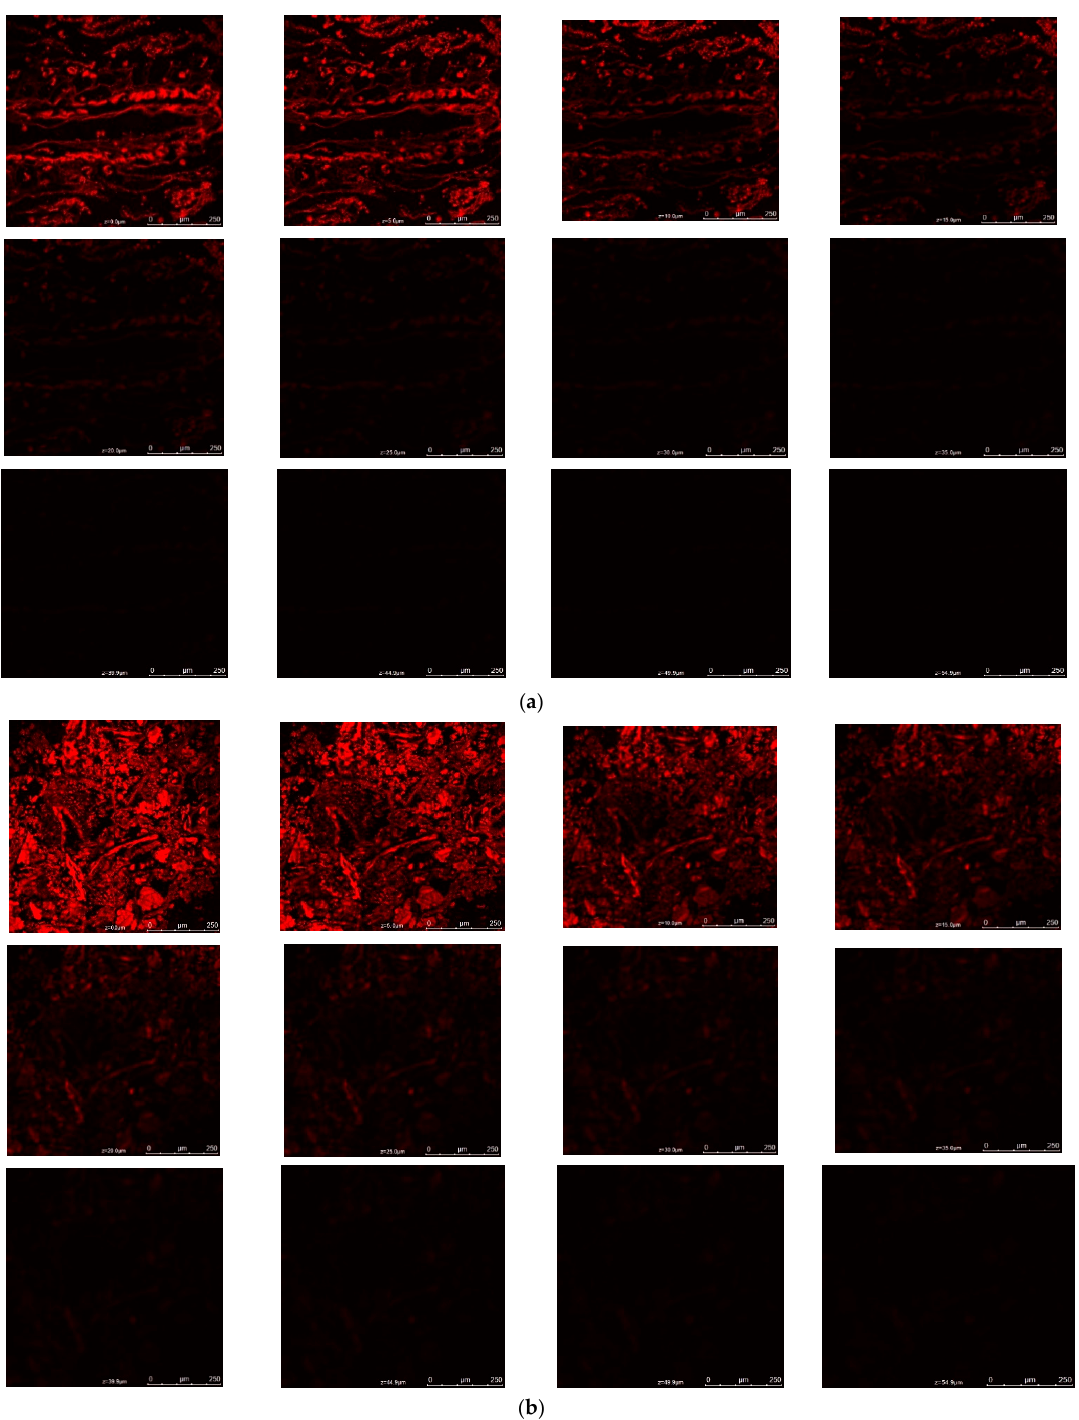
Figure 8. Confocal scanning images of drug permeation via ( a ) suspension and ( b ) SNEDDS across the intestinal membrane.